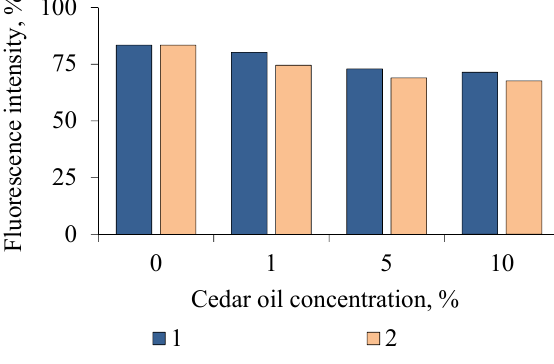
Fig. 5. Results of in vitro determination of the antioxidant effect of cedar oil on the cultured MDCK1 cells for 30 min: (1) oil (cold pressing); (2) oil (heat pressing). The data are expressed as a mean ± standard deviation ( n = 5).